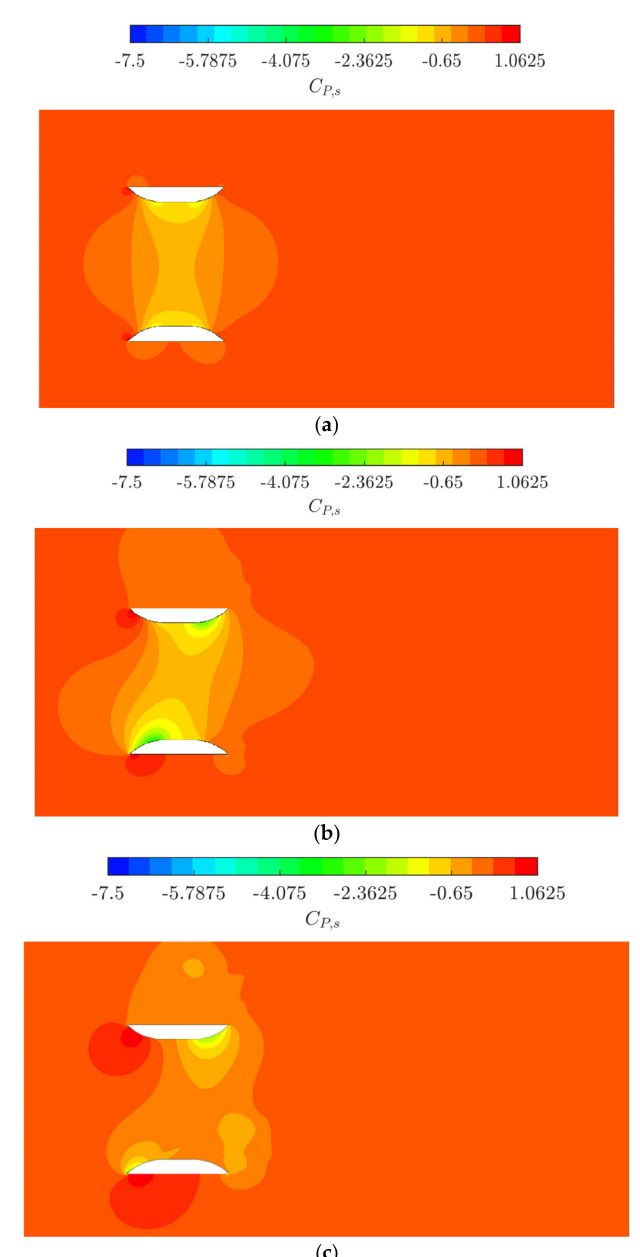
Figure 15. Illustrative cross-sectional representation of the pressure coefficient ( C P , s ) within the duct domain at distinct yaw angles ( U ∞ = 4 m.s − 1 ). ( a ) γ = 0 ◦ ; ( b ) γ = 23.2 ◦ ; ( c ) γ = 38 ◦